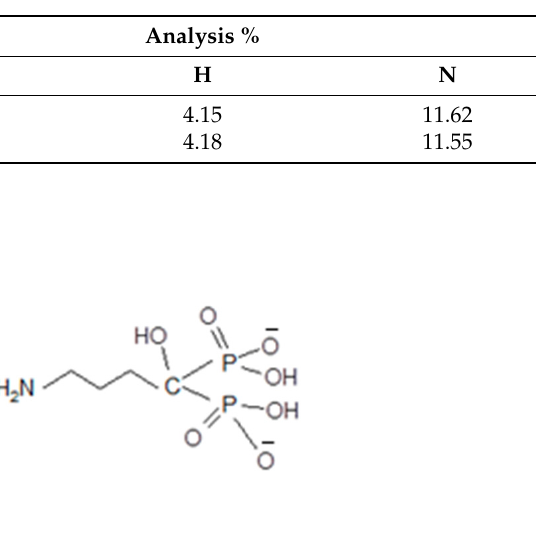
Figure 2. Structural formula of ALN o -phenanthroline-Iron (II) association complex. The three main components of taking a measurement with an ISE are an internal reference or standard solution and an outer analyte, or sample solution separated by a thin membrane. The potential developed at the membrane is the result of either an ion exchange process or an ion transport process occurring at each interface between the membrane and solution. At each solution–membrane interface, an ion exchange equilibrium is established (Scheme 1). The partitioning of ALN between the aqueous solution phase and the membrane phase depends on its activity or concentration. The resulting charge separation at each interface results in a phase-boundary potential [25–27].